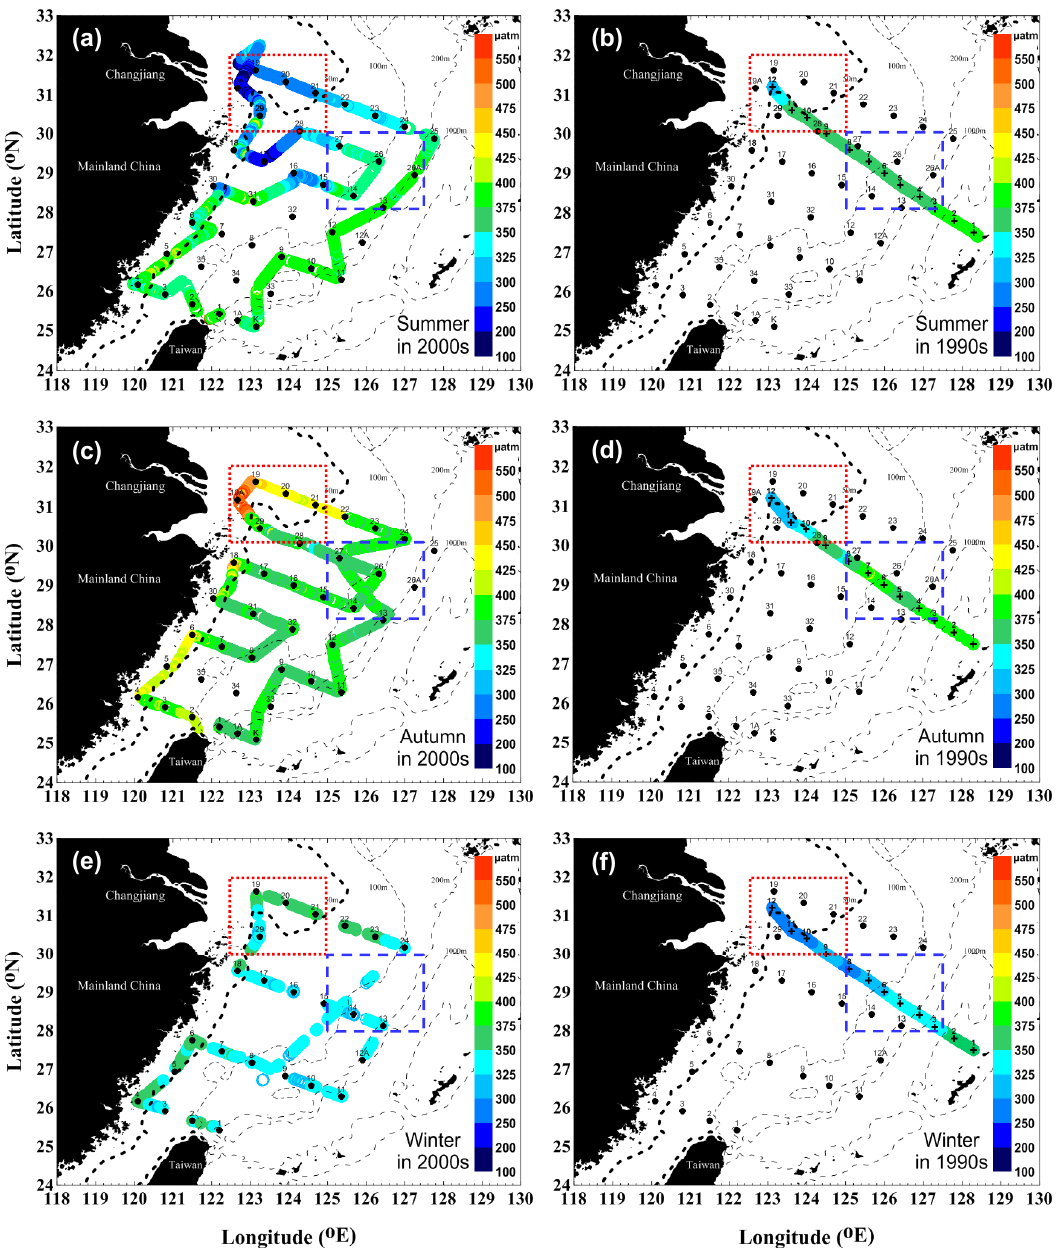
) in summer, autumn and winter on the entire East China Sea shelf in the 2000s Fig. 2. Spatial distributions of surface water p CO 2 ( p CO sw 2 (the left panel), and along the PN line in the 1990s (the right panel). The latter was reproduced by digitizing Fig. 2 of Tsunogai et al. (1999). The summer, autumn and winter p CO sw data in the 2000s and the 1990s were collected in July 2011, late October to early November 2011, 2 January 2008, August 1994, October 1993 and February 1993, respectively. The dotted rectangular area indicates the inner shelf region (30–32 ◦ N, 122.5–125 ◦ E) that is susceptible to the influence of the Changjiang discharge, whereas the dashed rectangular area indicates the outer shelf region (28–30 ◦ N, 125–127.5 ◦ E) that is generally away from the influence of the Changjiang discharge. The bold dotted line indicates the 50m